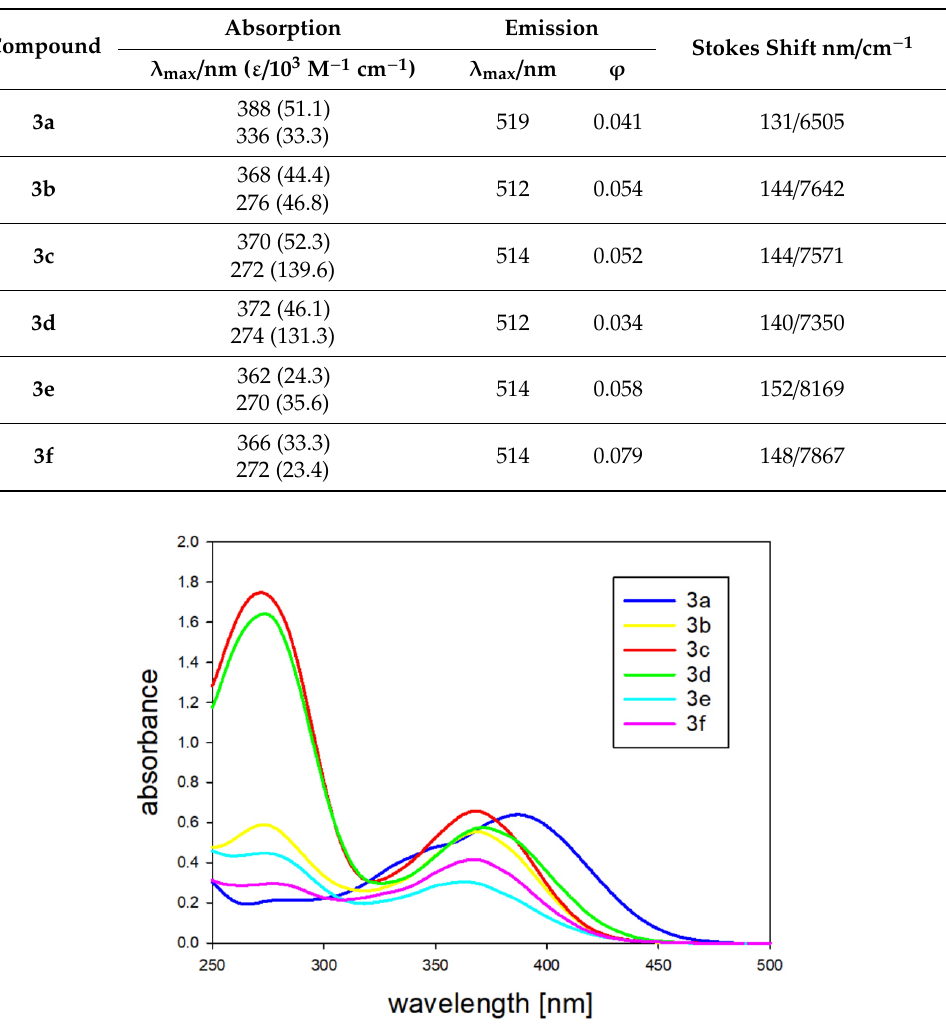
Figure 3. UV–Vis absorption spectra of the Schi ff bases 3a – f in ethanol (1.25 × 10 − 5 Figure 3. UV– Vis absorption spectra of the Schiff bases 3a – f in ethanol (1.25 × 10 − 5 M).